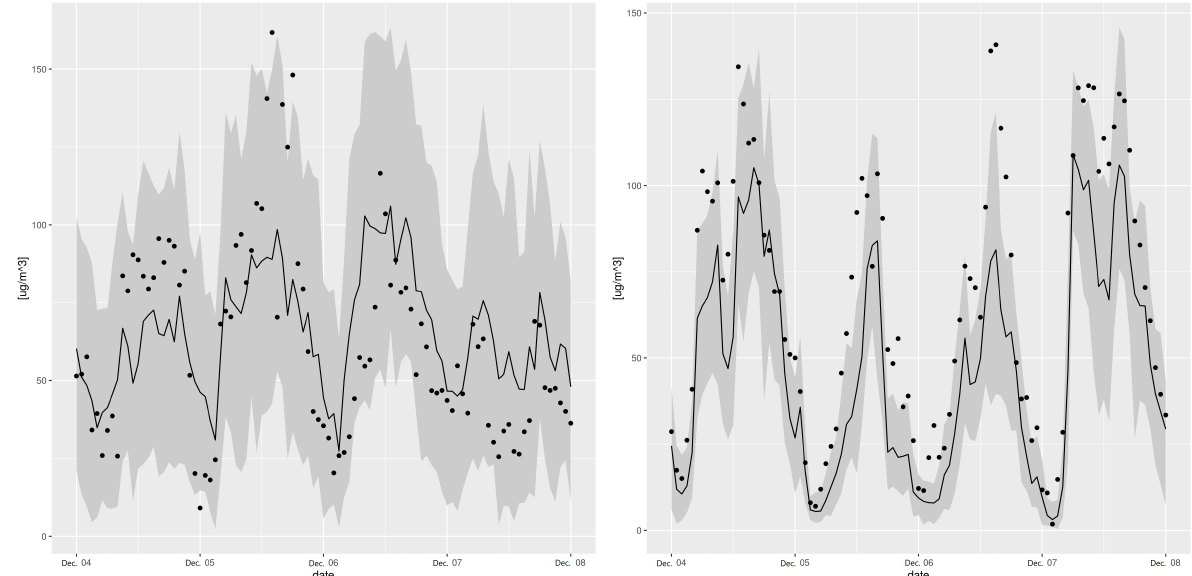
Figure 8. Sample of observations (dots) timeseries with the RFreg prediction (line), the error prediction at CI95 (gray area) following Lu 2019 at station 11 between 4 December 2016 and 8 December 2016 ( left ), following Lu 2019 at station 504, one year earlier, between 4 December 2015 and 8 December 2015 ( right ).